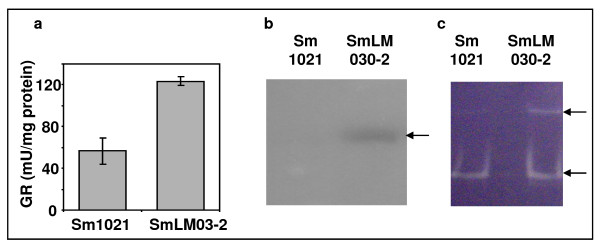
Activity of enzymes combating oxidative stress. Enzymatic activities of (a) glutathione reductase as measured spectrophotometrically at 412 nm; (b) catalase and (c) superoxidase dismutase in native gel after staining. Total protein extracts were obtained after growing the wild-type strain Sm1021 and the tolC mutant strain SmLM030-2 for 20 hours in GMS medium. 20 μg of crude extract were loaded in each lane. Arrows indicate the position of bands obtained.